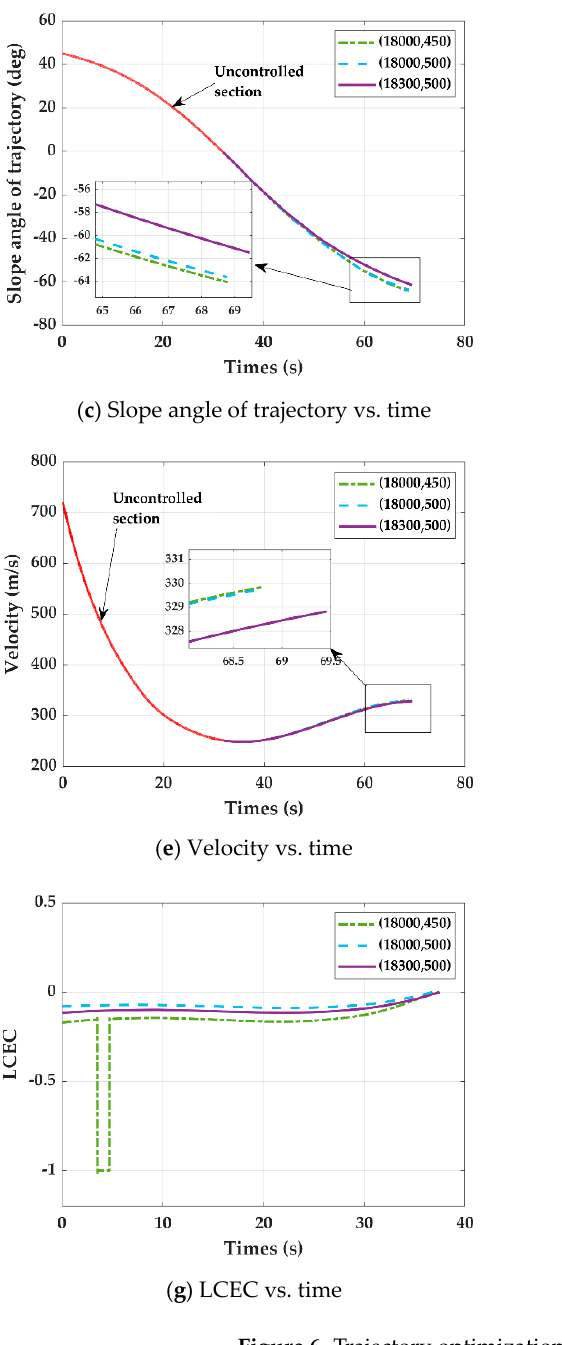
Figure 6. Trajectory optimization of different impact points.